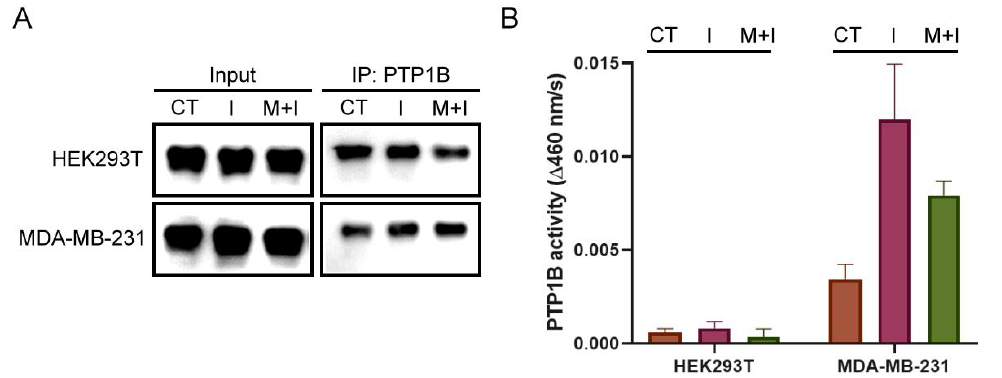
Figure 6. In situ PTP1B activity in insulin- or combined insulin and metformin-treated HEK293T and MDA-MB-231 cells: ( A ) Immunoprecipitation of PTP1B from the insulin- or combined insulin and metformin-treated HEK293T and MDA-MB-231 cell lysate. ( B ) The PTP1B activity of each sample of immunoprecipitation. I: 10 ng/mL insulin for 2 h; M + I: 10 mM metformin (15 mM metformin for MDA-MB-231 cells) + 10 ng/mL insulin for 2 h. ( n = 3).